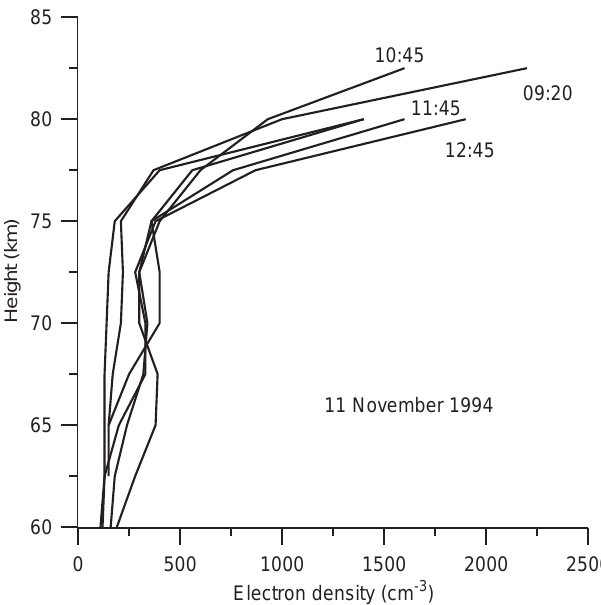
Fig. 7. Development of the electron density profile over Nizhni Novgorod during 11 November, 1994. Two profiles without time information were measured at 13:45 and 14:45 (all times are local times). The latter provides the lowest electron densities in 65–75 km. The corresponding solar zenith angles vary between 74 (cid:176) (11:45) and 81 (cid:176) (09:20 and 14:45)